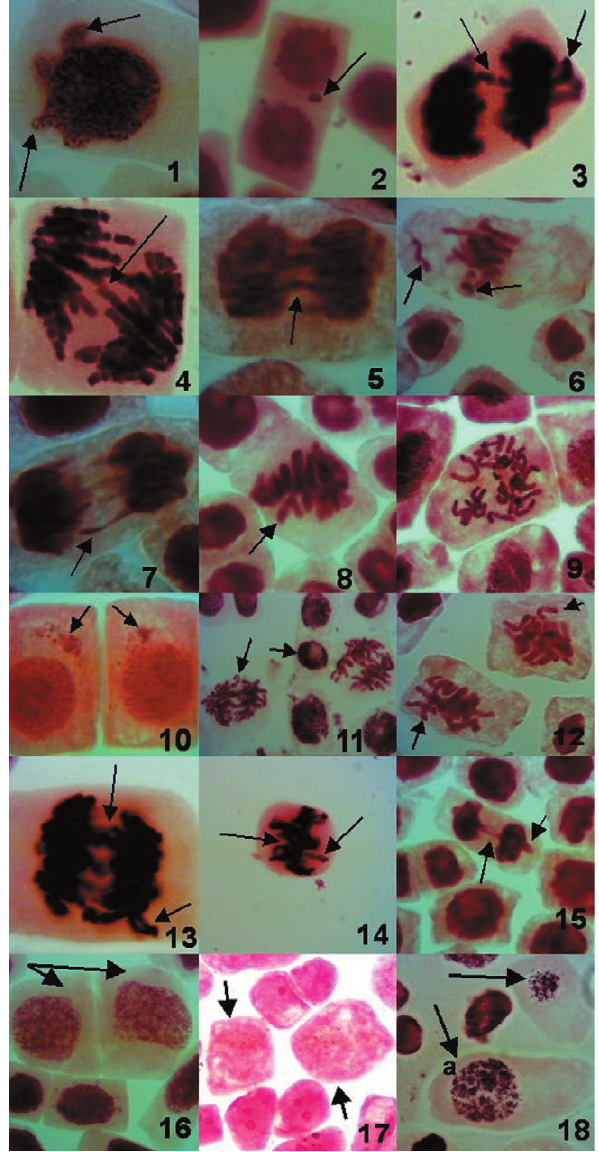
Figure 4. Chromosome and mitotic abnormalities in the roots